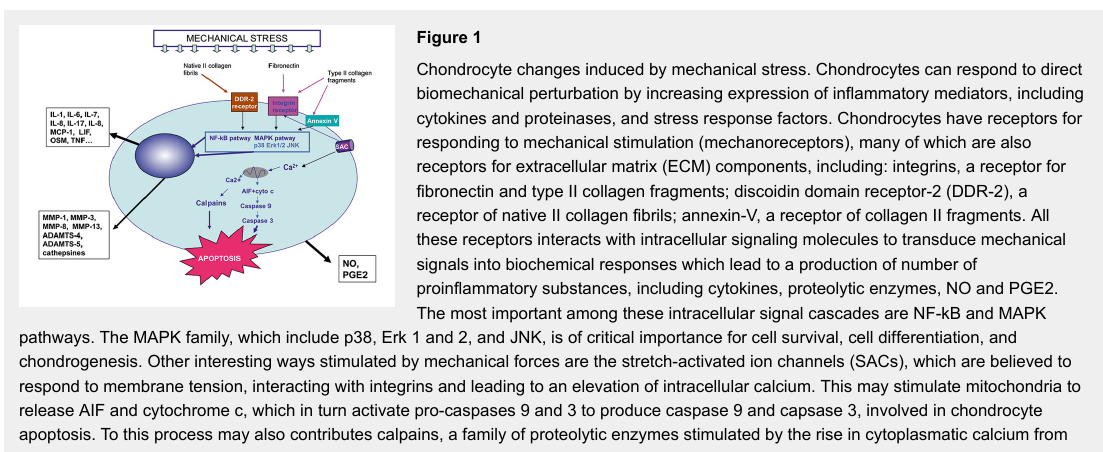
Most relevant biomarkers in osteoarthritits.